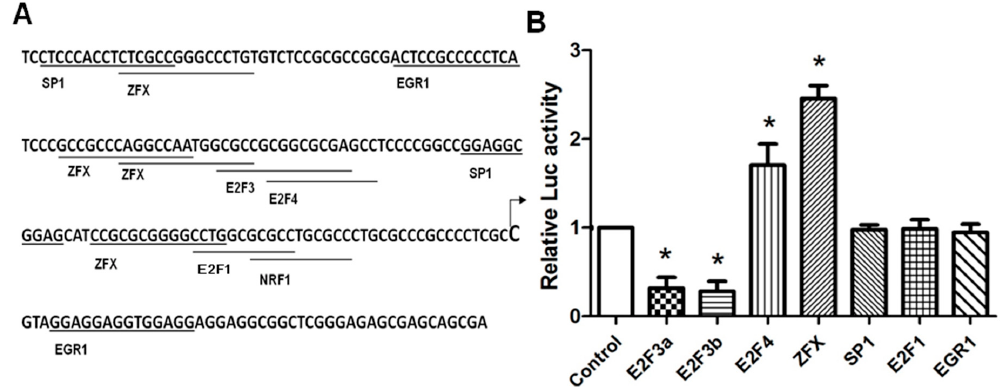
Figure 2. Identification of crucial transcription factors controlling SET transcript 2 expression.